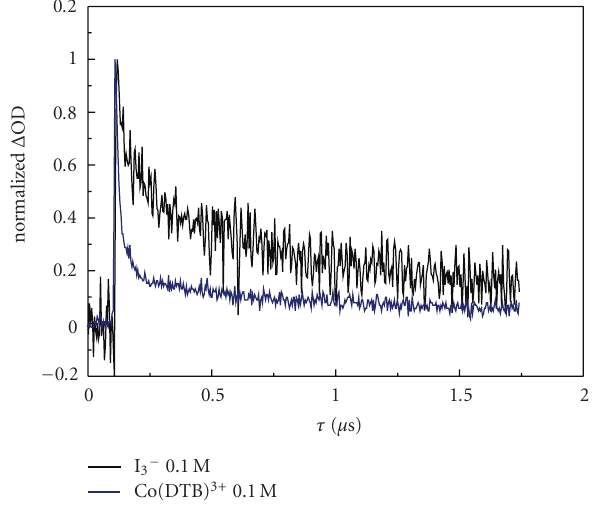
Figure 17: Di ff erential absorption decays for Ru(III) recovery observed at 750 nm in the presence of equimolar amounts of I − and Co(III) in acetonitrile +0 . 5M Li + . Excitation energy density ≈ 1mJ/cm 2